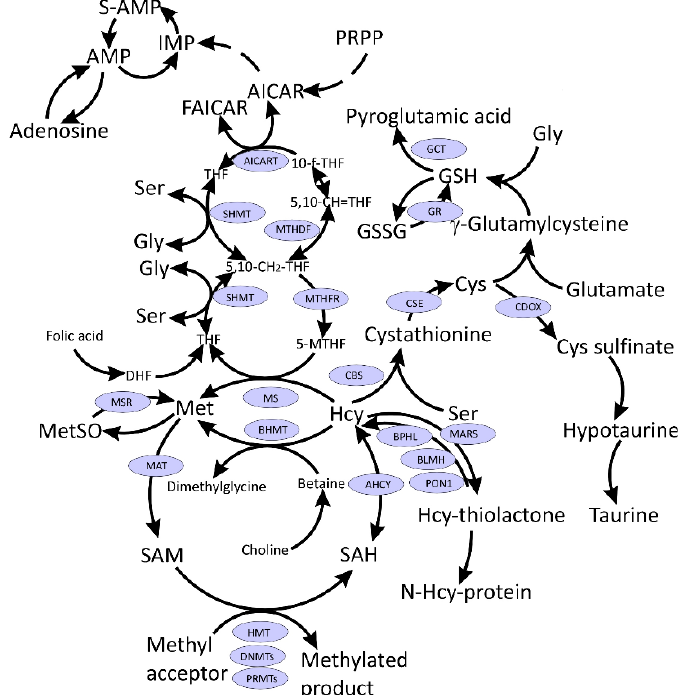
Figure 1. Interconnections between metabolism of folate, one-carbon, and sulfur compounds. Indicated metabolites are discussed in the text. CysGly, a product of GSH catabolism, affected in COVID-19 and discussed in the text, is not shown.